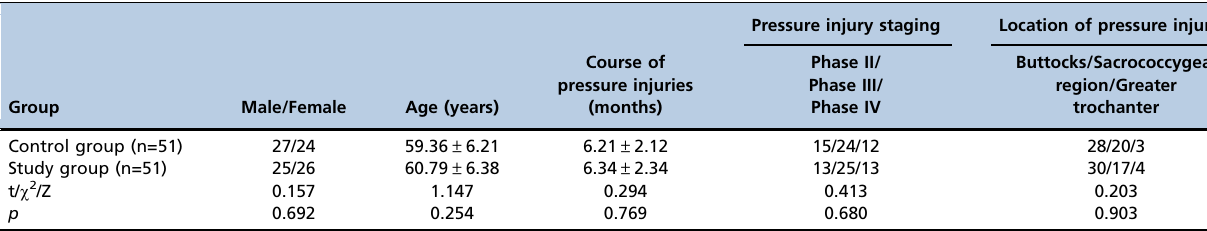
Table 1 - Comparison of baseline data.